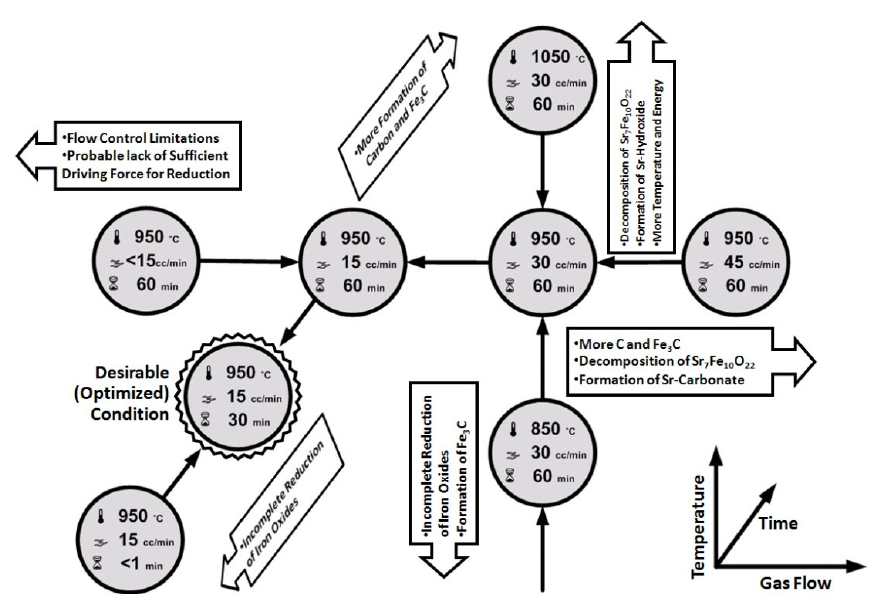
Figure 4. Schematic optimization plan to achieve the best product from gas heat treatment.